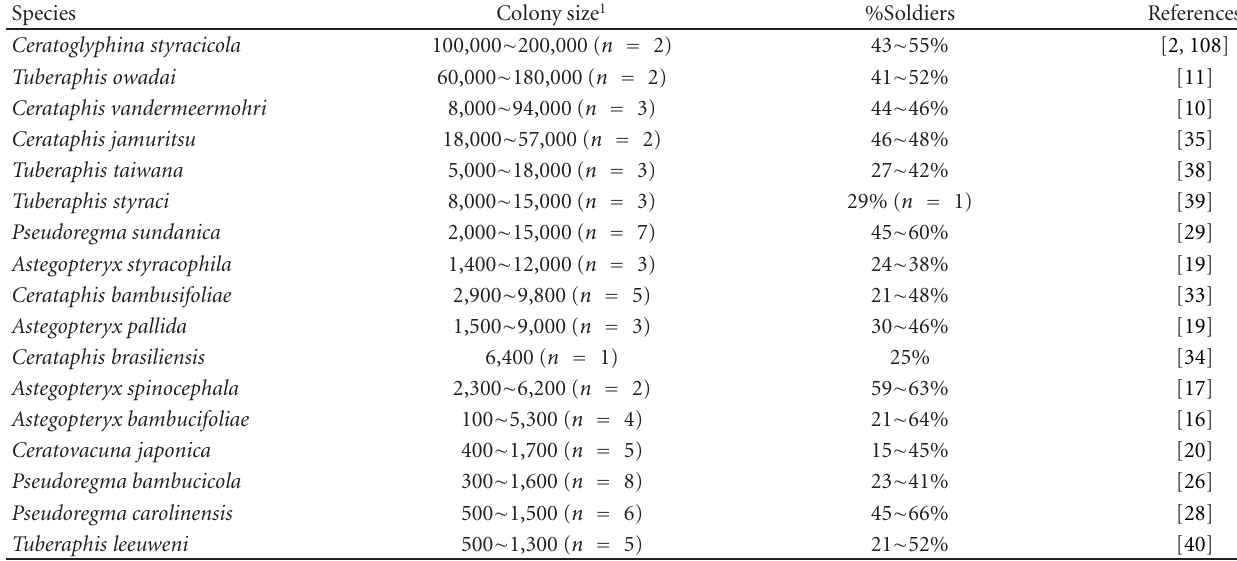
Table 3: Colony size and the percentage of soldiers in cerataphidine